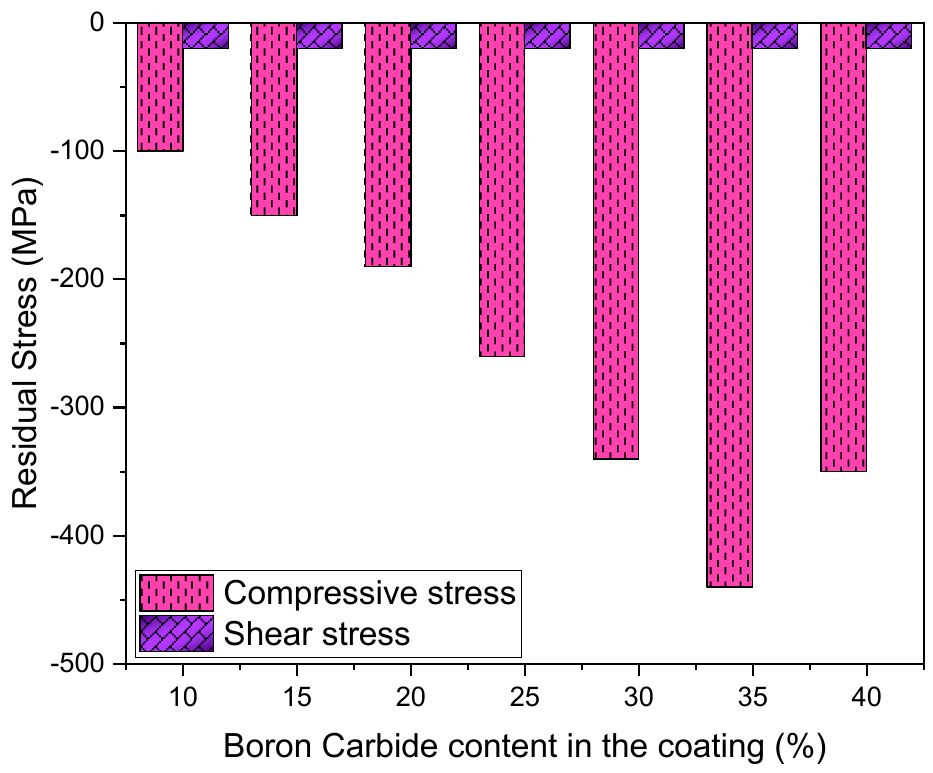
Figure 7. The residual stress of different B 4 C/Ni63 coatings. The fracture toughness of different Boron carbide/Ni63 coatings with various compositions were given in Figure 8.